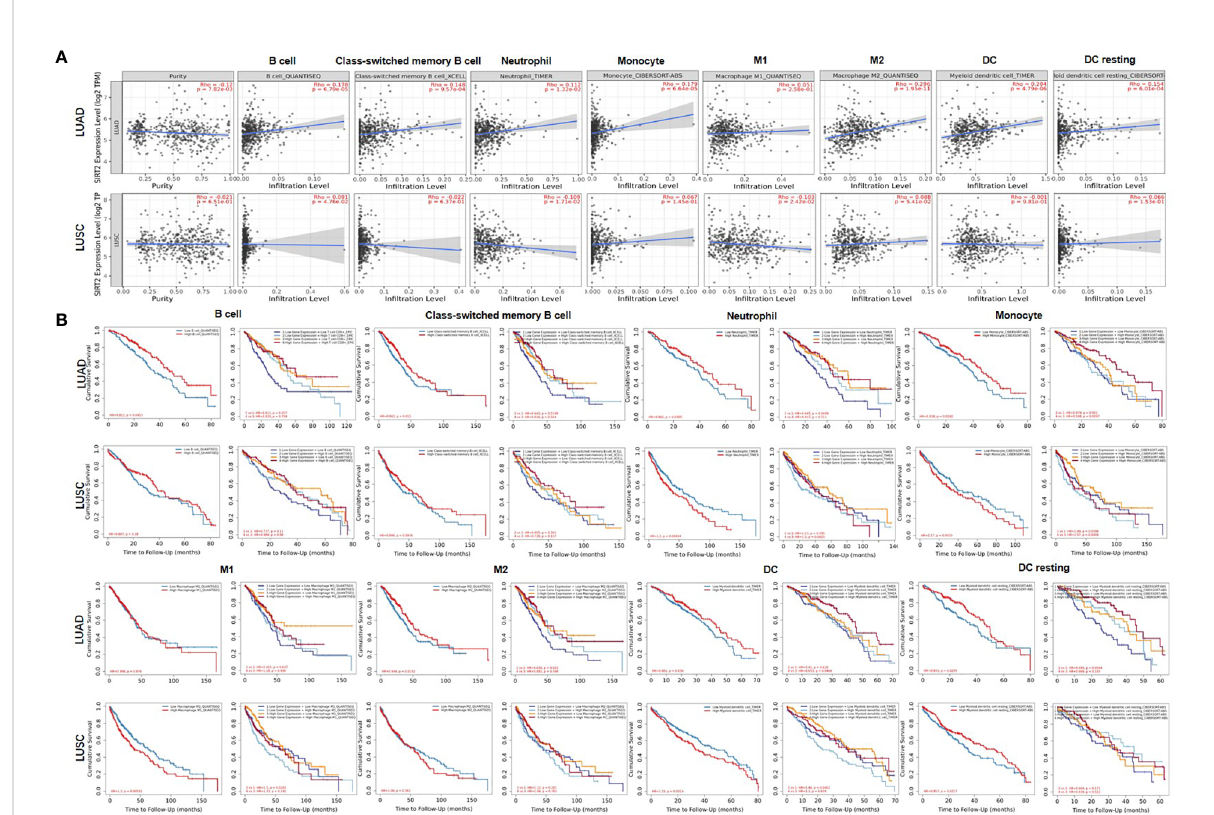
FIGURE 5 Correlation between SIRT2 expression and immune in fi ltration level in (A) LUAD and (B) LUSC. (A) SIRT2 expression was strongly negatively correlated with tumor purity but strongly positively correlated with the level of B cells, Class-switched memory B cell, neutrophils, monocyte, M1, M2 and DCs in LUAD ( n = 515). (B) SIRT2 expression is weak positive and signi fi cantly negative correlations with in fi ltrating levels of B cell, neutrophils and M1 in LUSC but a signi fi cant correlation was not found between SIRT2 expression and the in fi ltrating levels of B cells, CD8+ T cells, macrophages and DCs ( n =